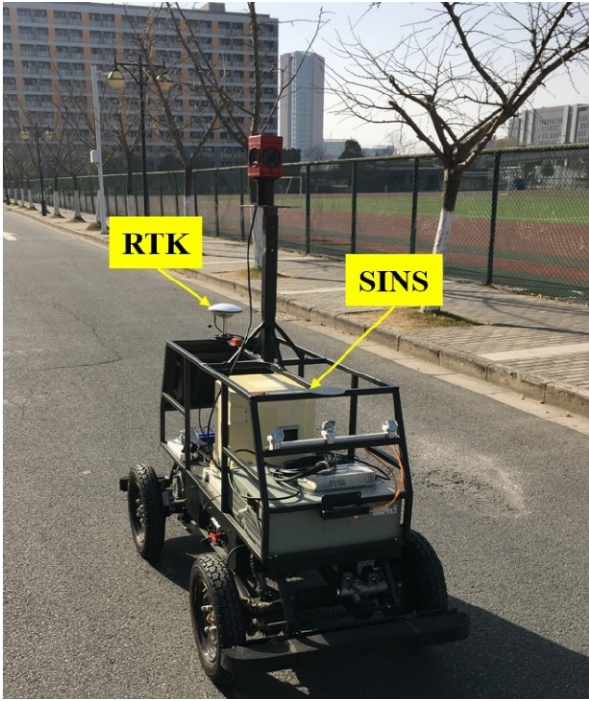
Figure 6. The experimental vehicle. The parameters of the vehicle experiment are listed in Table 2. Table 2. The parameters of the vehicle experiment.